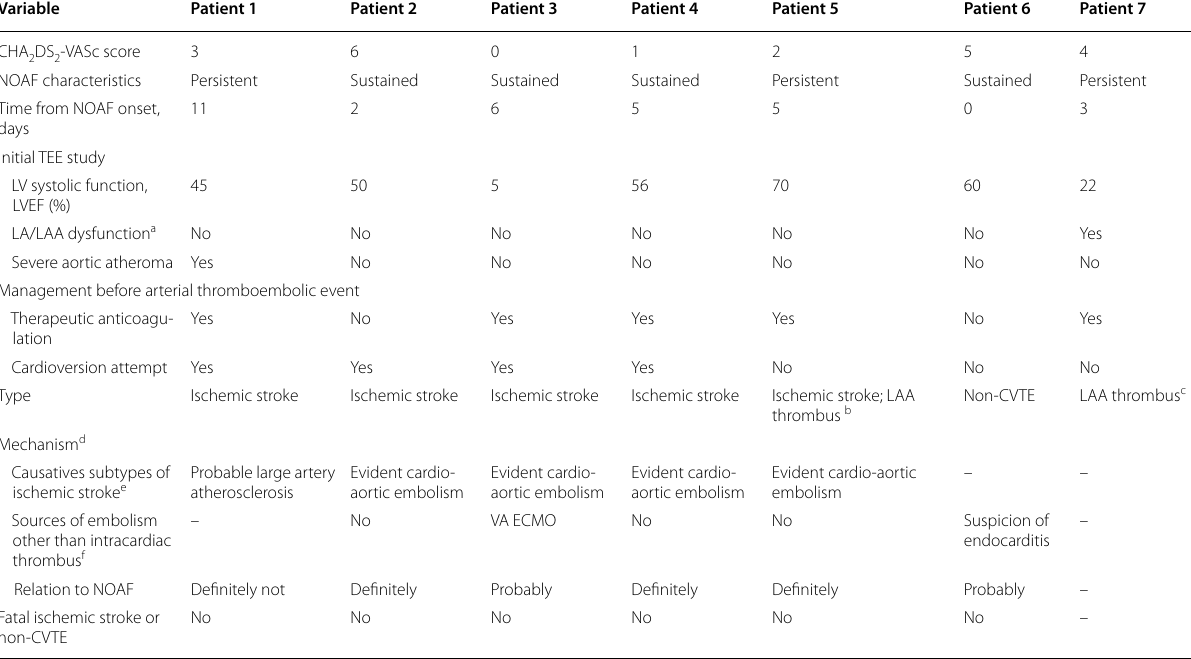
Table 3 Description of 28‑day arterial thromboembolic events